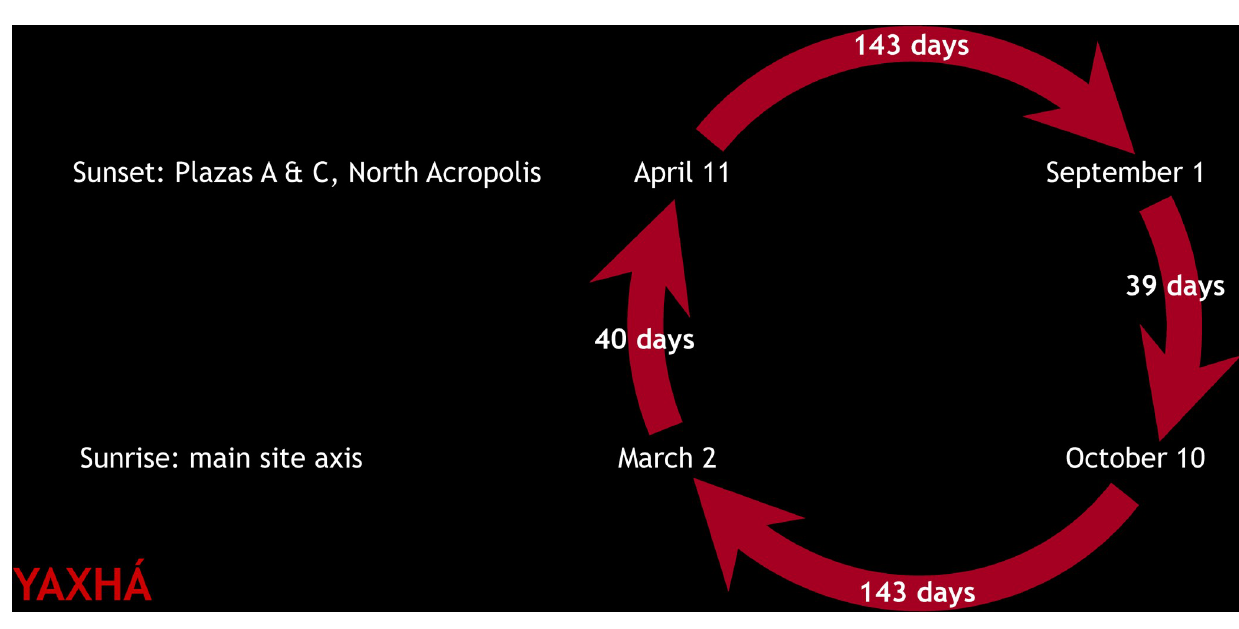
Fig 13. Possible observational calendar of